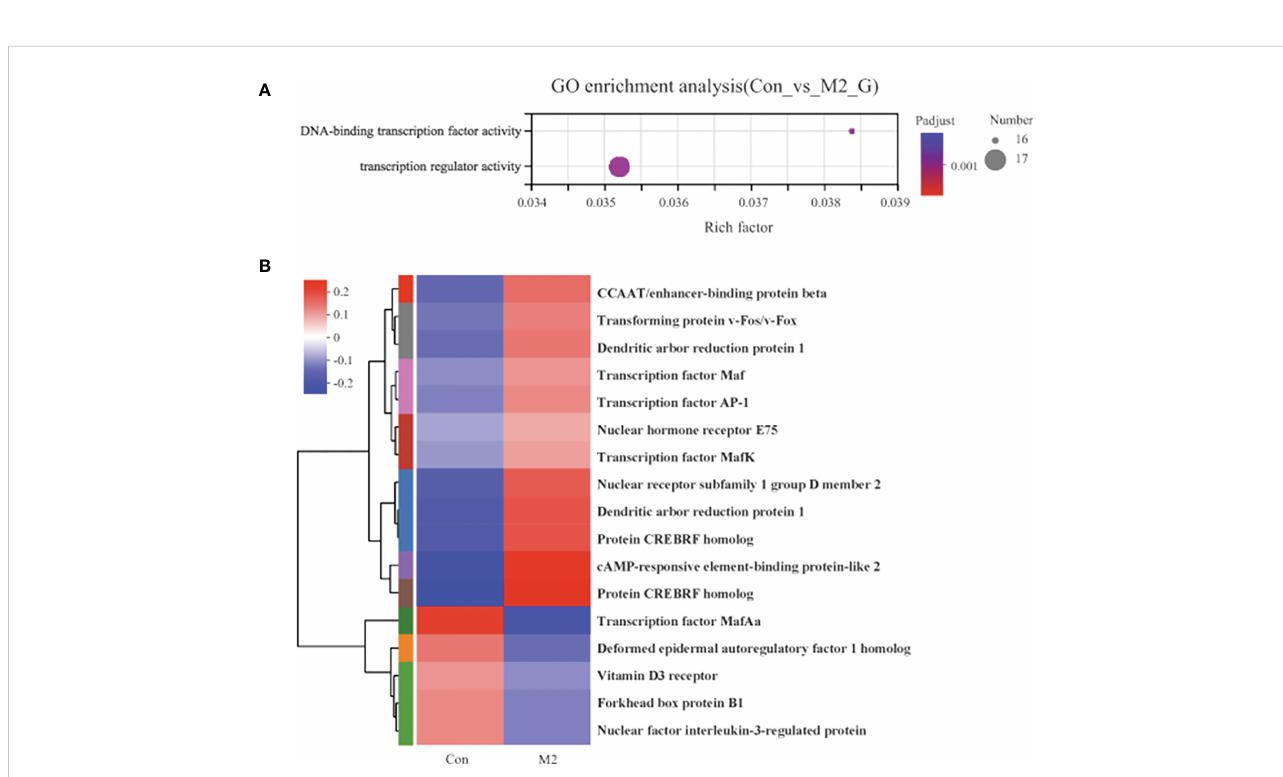
FIGURE 4 The functional enrichment and expression analysis of initial-response genes to oyster induction. (A) GO enrichment results of 92 DEGs in Con vs. M2 comparison. (P adjust < 0.05). (B) Heat map of the expression analysis of 17 DEGs in GO:0003700 (DNA-binding transcription factor activity) and GO:0140110 (transcription regulator